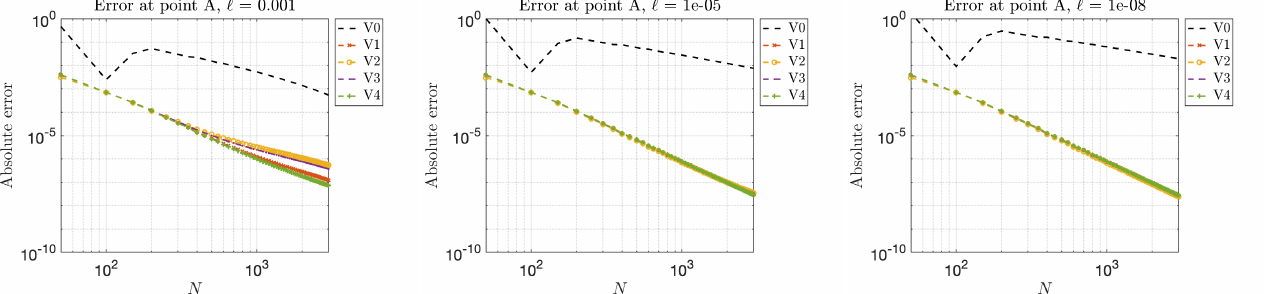
Figure 3. Laplace 2D single-layer. Log-log plots of the errors with respect to N made in computing the solution at some distance (cid:96) along the normal from point A plotted as black × ’s in Figure